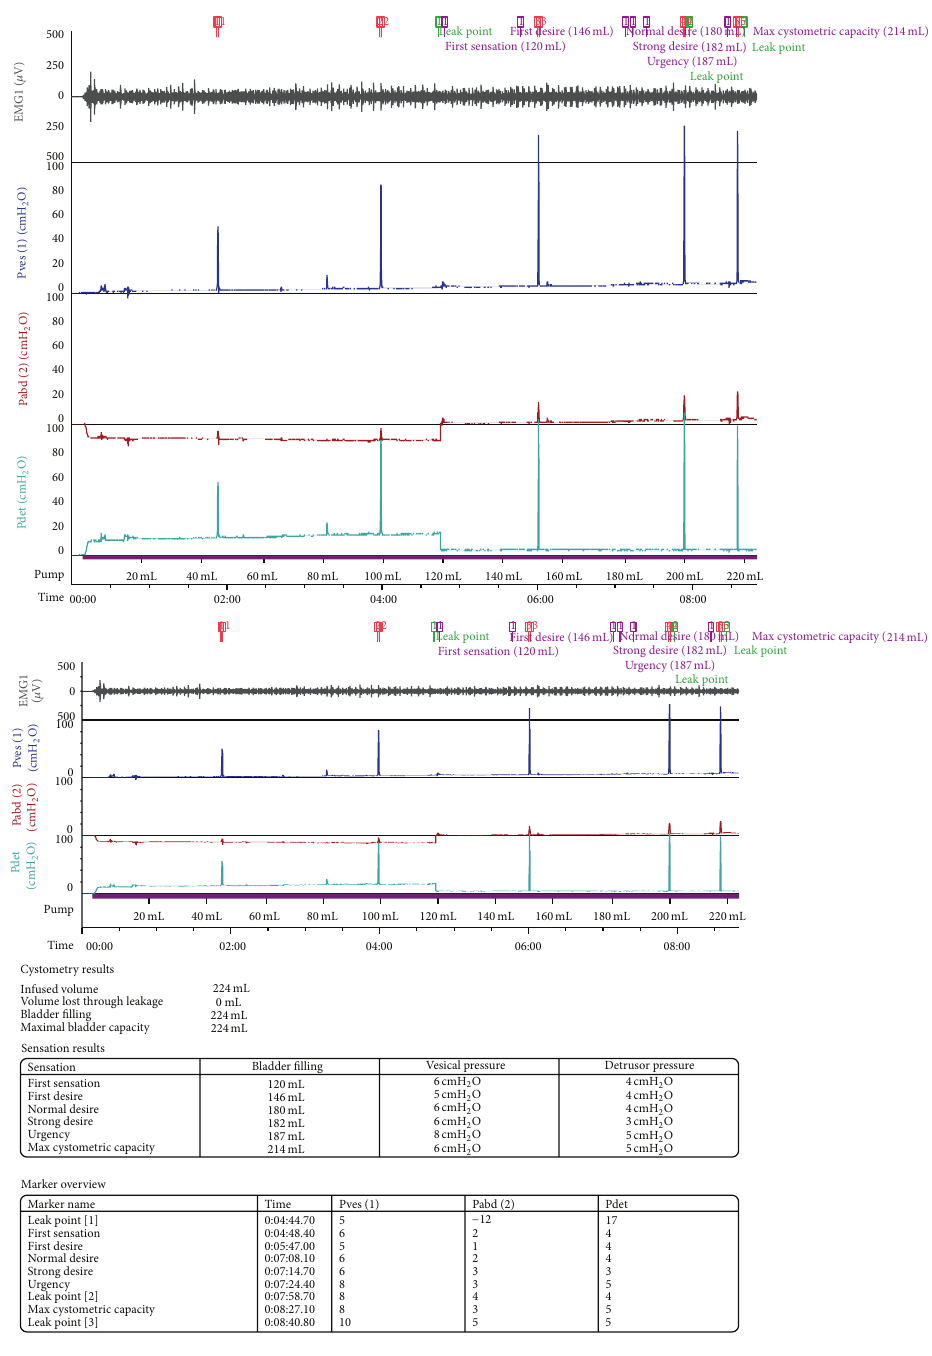
Figure 3: Postoperative